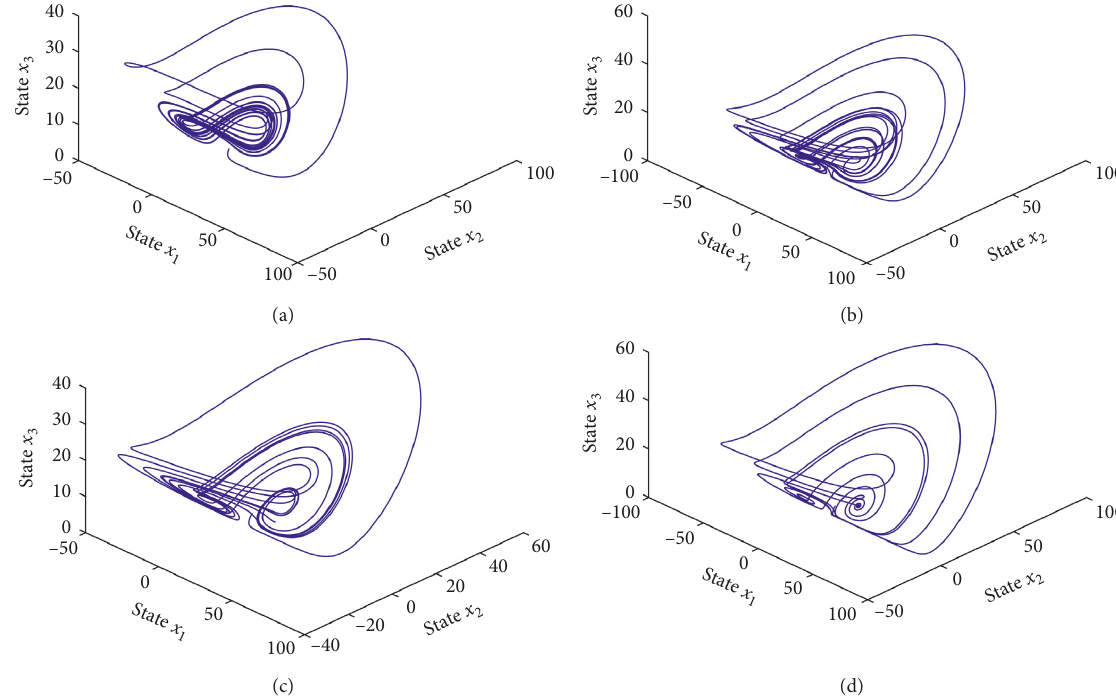
Figure 2: The attractor of the new tempered fractional system with different λ